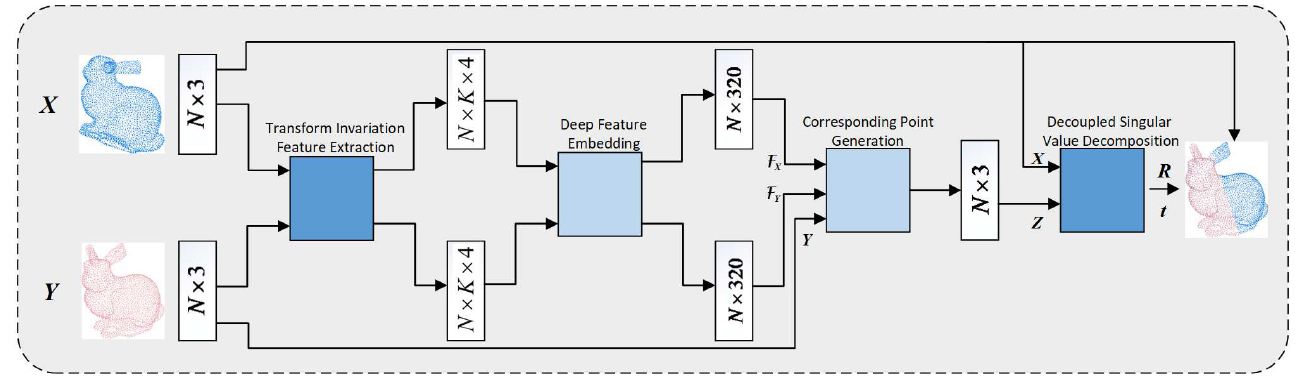
Figure 2. The architecture of the